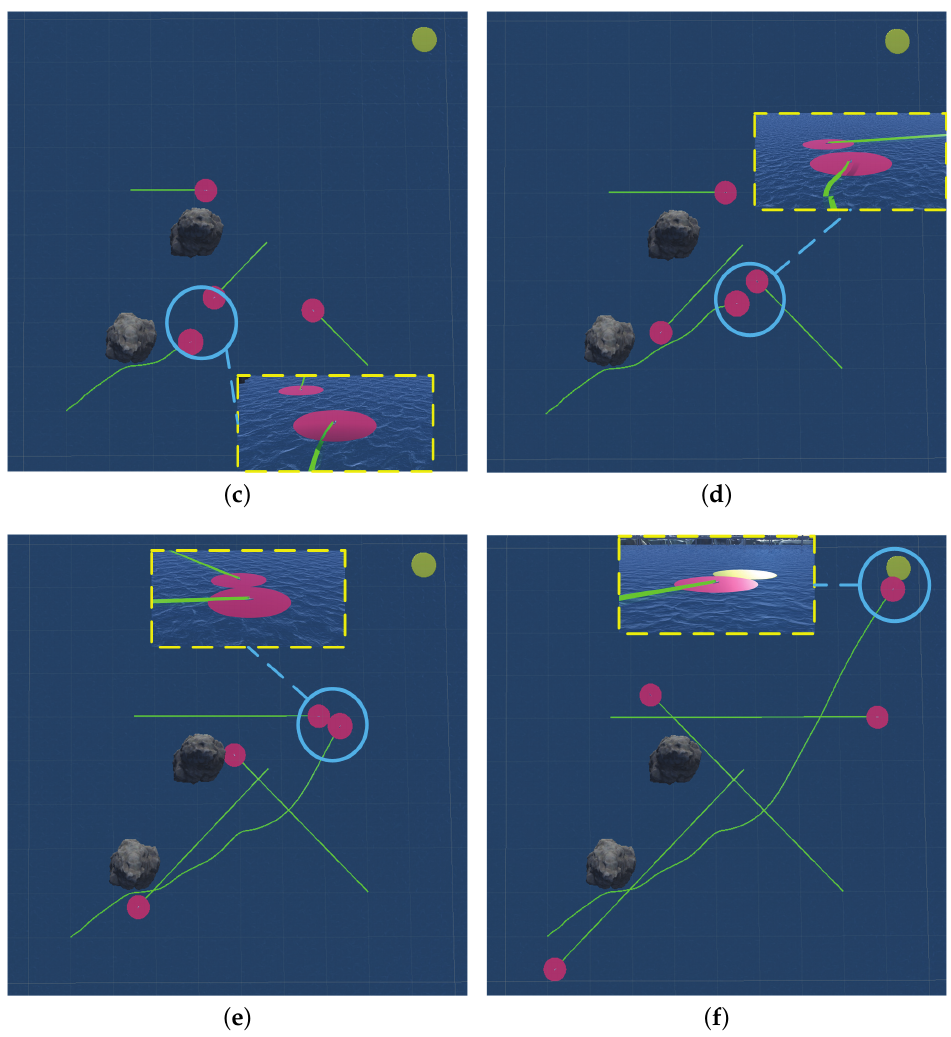
Figure 15. Multi-USVs collision avoidance environment. ( a ) Test stage 1; ( b ) Test stage 2; ( c ) Test stage 3; ( d ) Test stage 4; ( e ) Test stage 5; ( f ) Test stage